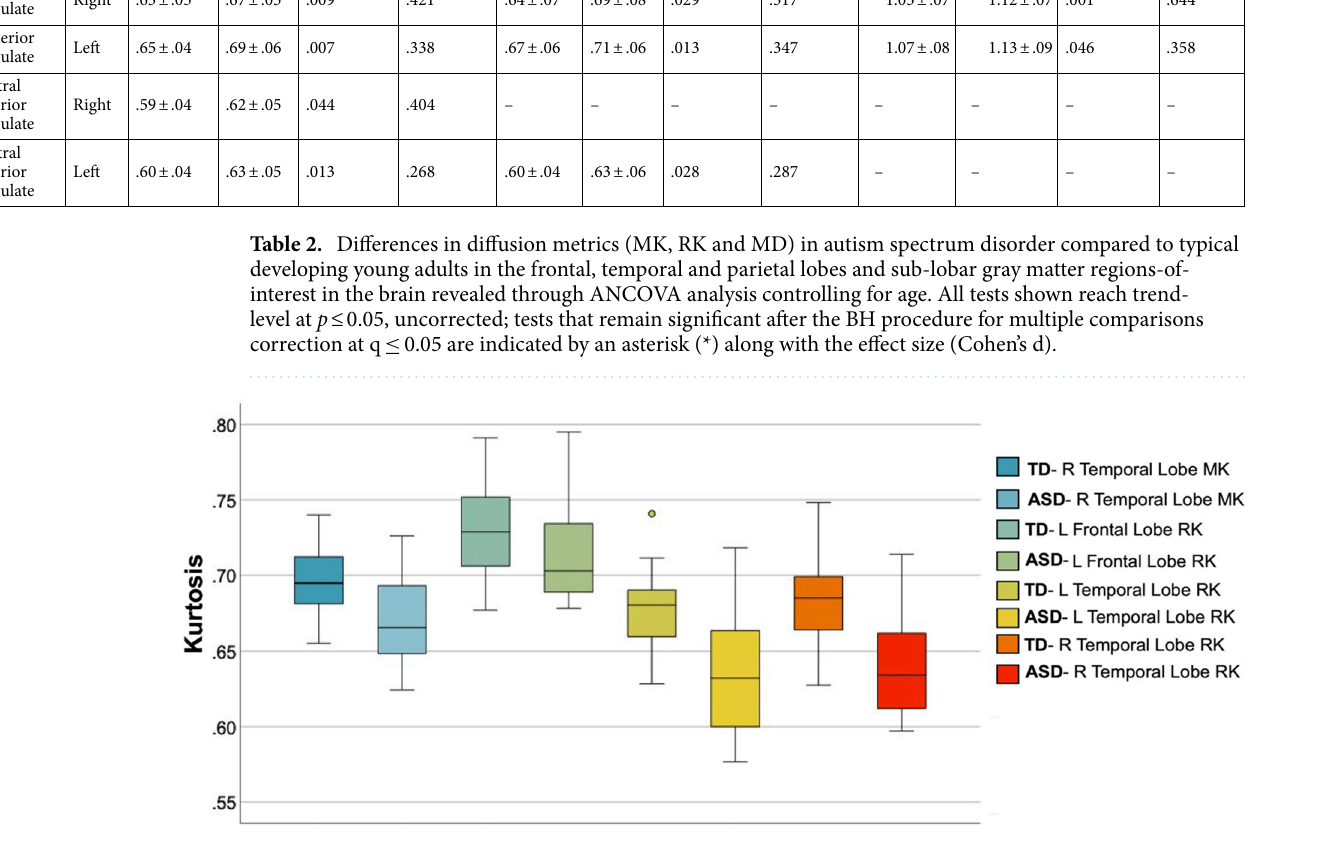
Figure 1. Decreased MK and RK in the right and left temporal lobe GM, and decreased RK in the left frontal lobe GM are observed in autism spectrum disorder compared to the typically developing group. All results shown were significant after ANCOVA between-group tests controlling for age and correcting for multiple comparisons (q ≤ .05 BH